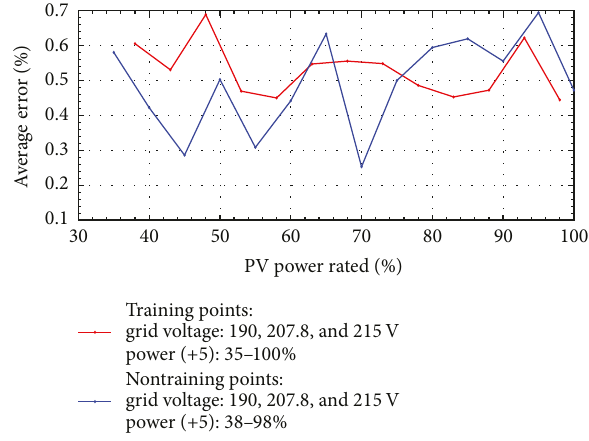
Figure 12: The average error between DDM and real measurement at training point and nontraining point for grid voltage equal to 190, 207.8, and